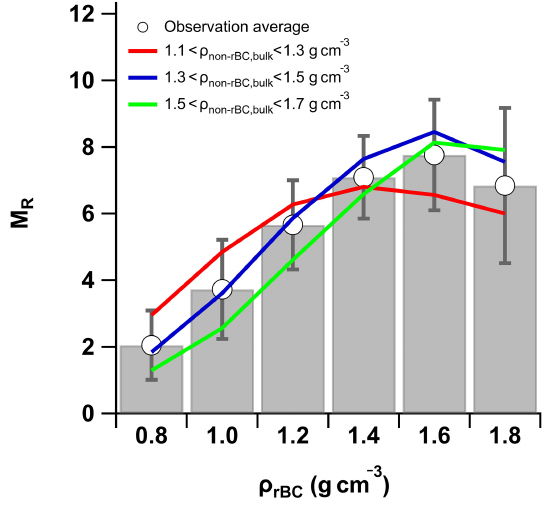
Figure 4. Variation in mass ratio ( M R ) of coatings to rBC as a func- tion of ρ rBC